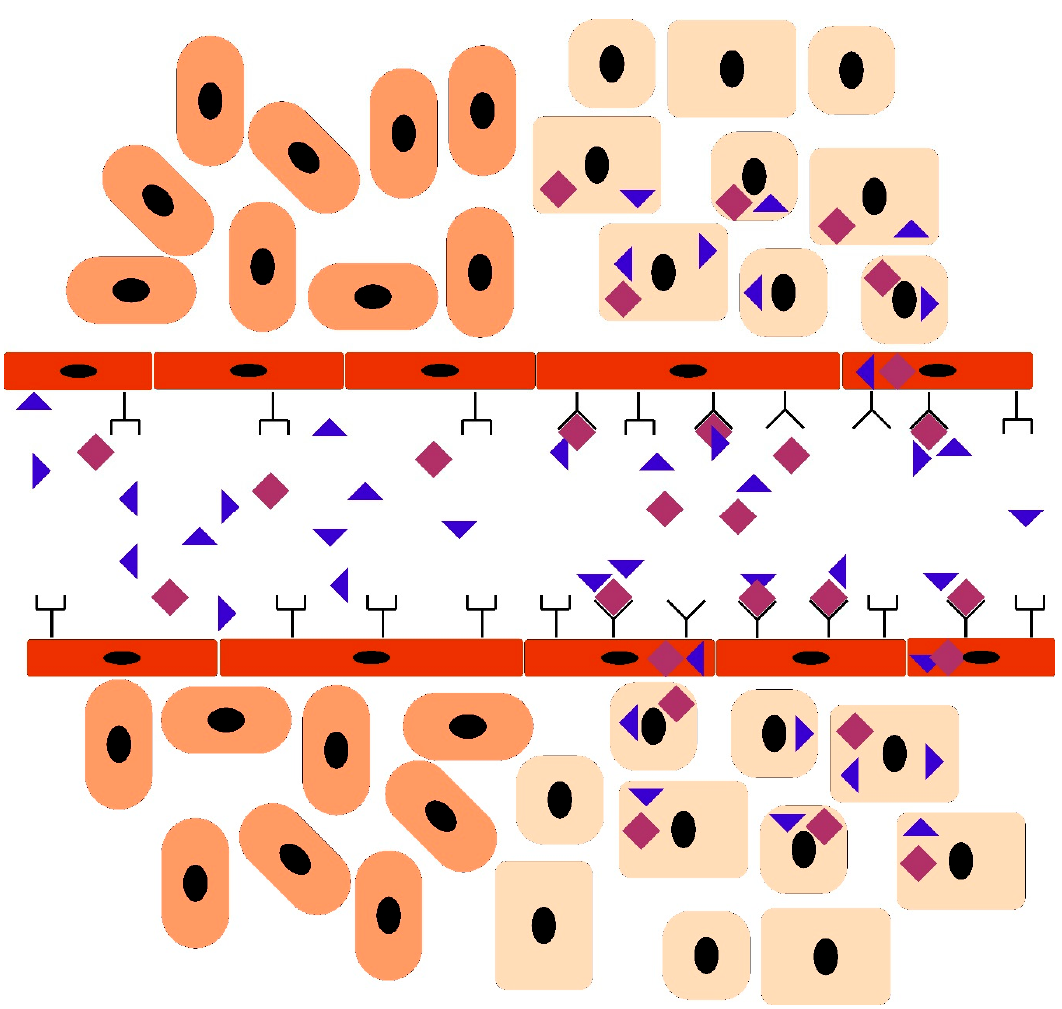
Figure 4. The bystander effect enables delivering a therapeutic into the tissue without a covalent link between the therapeutic and the homing peptide. The drawing represents the homing of a peptide (diamond) to its target tissue (cuboidal cells) and the bystander effect created by the peptide. The tissue on the right has the receptor for the homing peptide (Y-shape). When the peptide binds to its receptor, it opens a pathway for the therapeutic molecule (triangle) to pass through the vascular wall endothelium and enter the tissue parenchyma.